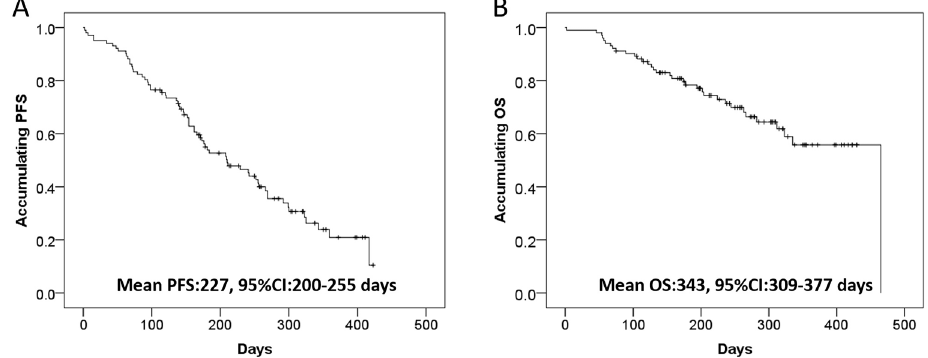
Figure 1. Progression-free survival (PFS) and overall survival (OS) in hepatocellular carcinoma patients treated by drug-eluting bead transarterial chemoembolization. Kaplan-Meier curve and log-rank test were used. P o 0.05 was considered signi fi cant.